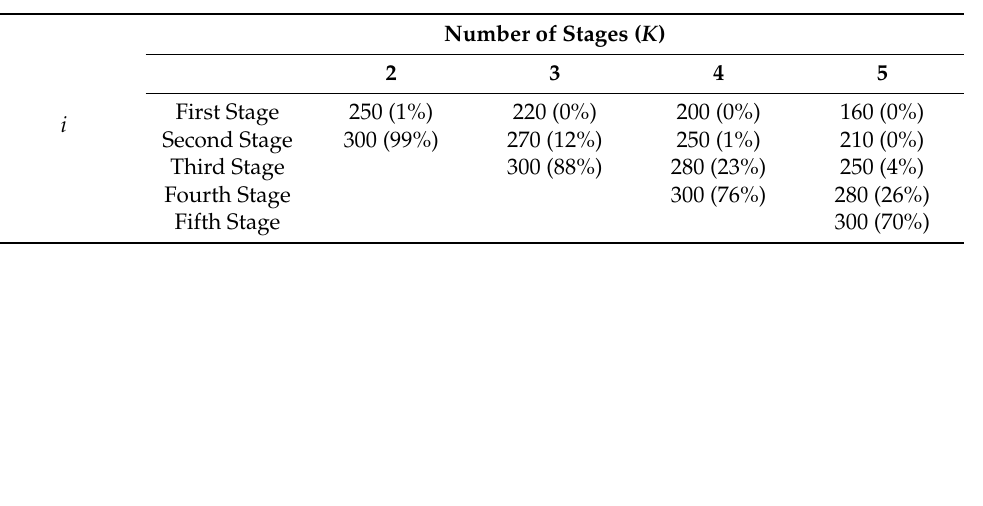
Table 8. Based on 5% of the 500,000 iterations, values for sample sizes and acceptance rates at stage i when H 0 is